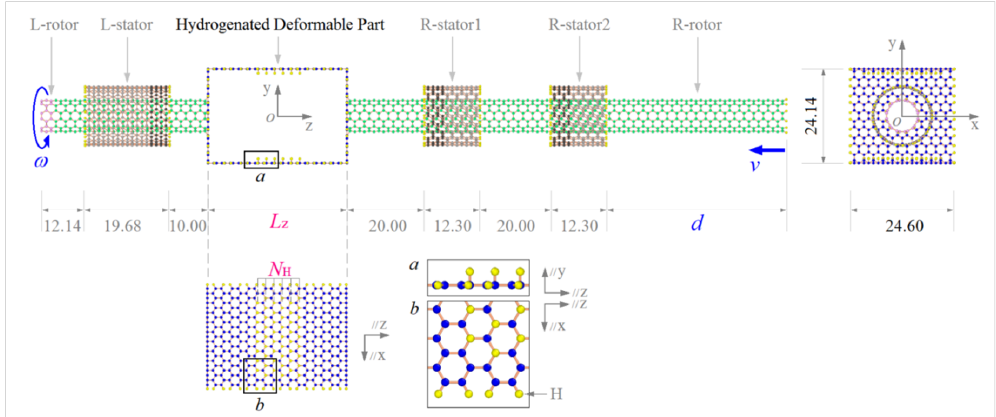
12 of 17 Figure 10. Equilibrium positions (mean values of d ) and oscillation amplitudes of the R-rotor connected with the HDPs that had different lengths at 8 K between 9 ns and 10 ns. 3. Materials and Methods 3.1. Model In this work, the model shown in Figure 11 was adopted to design a nanoconvertor for translating rotation into motion. When a rotational speed, i.e., ω , is exerted on the left end of a rotor, the HDP deforms under a centrifugal force and moves away from the rotational axis of the rotor. Simultaneously, asymmetric van der Waals (vdW) forces on both surfaces of the HDP lead to a reverse deformation. When the two deformations reach a dynamic equilibrium state, the value of d will have a stable fluctuation, which can be used to design a perfect nano-oscillator. For a deep understanding of the dynamic oscillation behavior of the R-rotor during rotation, more factors,